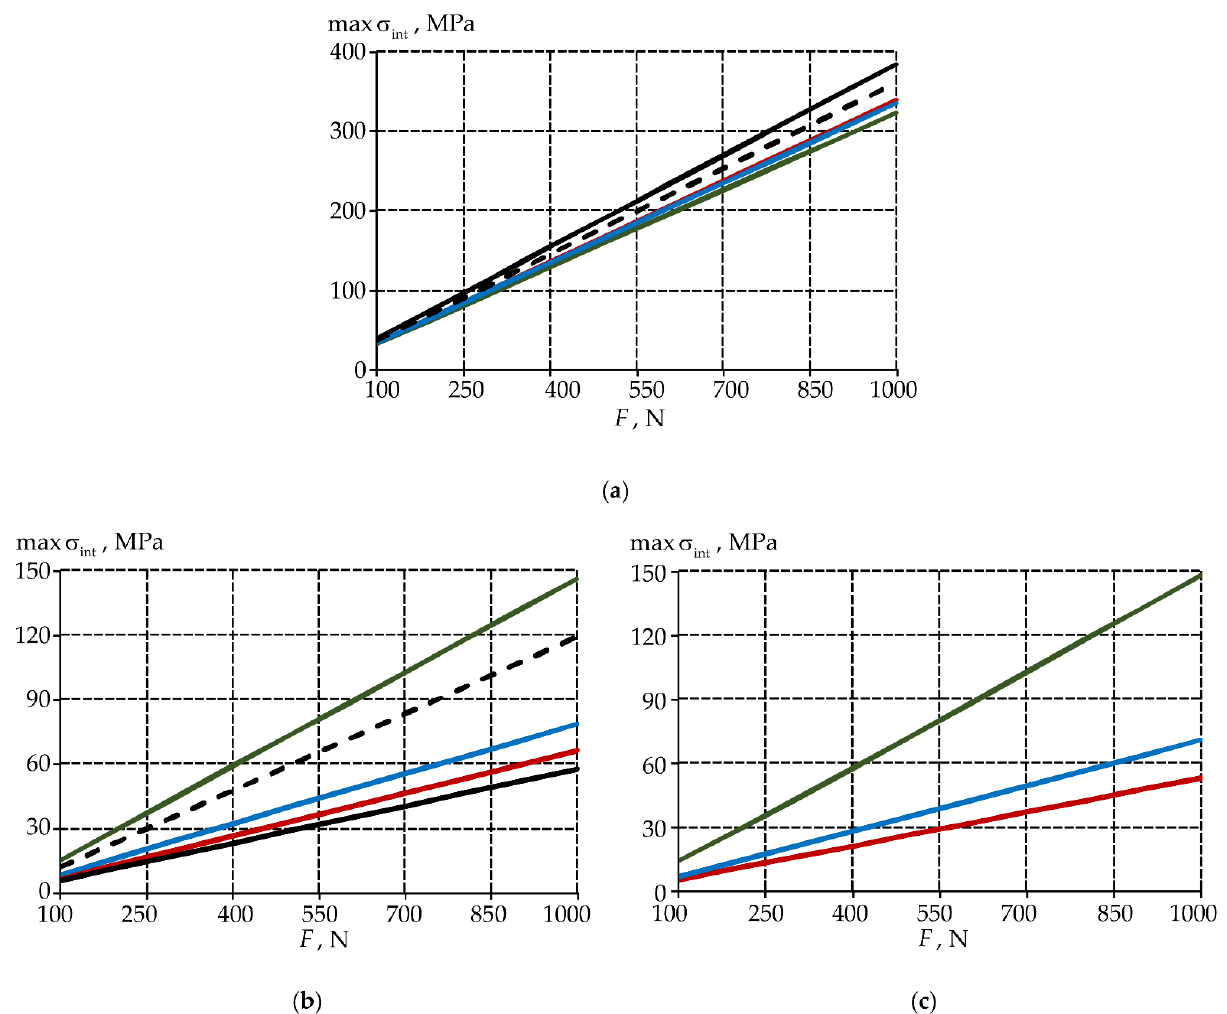
Figure 8. Dependence of the maximum values of the biomechanical assembly stress intensity on the load: ( a ) is enamel; ( b ) is dentine; ( c ) is inlay; black (solid line) is model without defect; black (dotted line) is model with defect; green is model with material 1 inlay, red is model with material 2 inlay, blue is model with material 3 inlay. Table 3. Comparison max σ int (%) in the biomechanical assembly elements of different models.